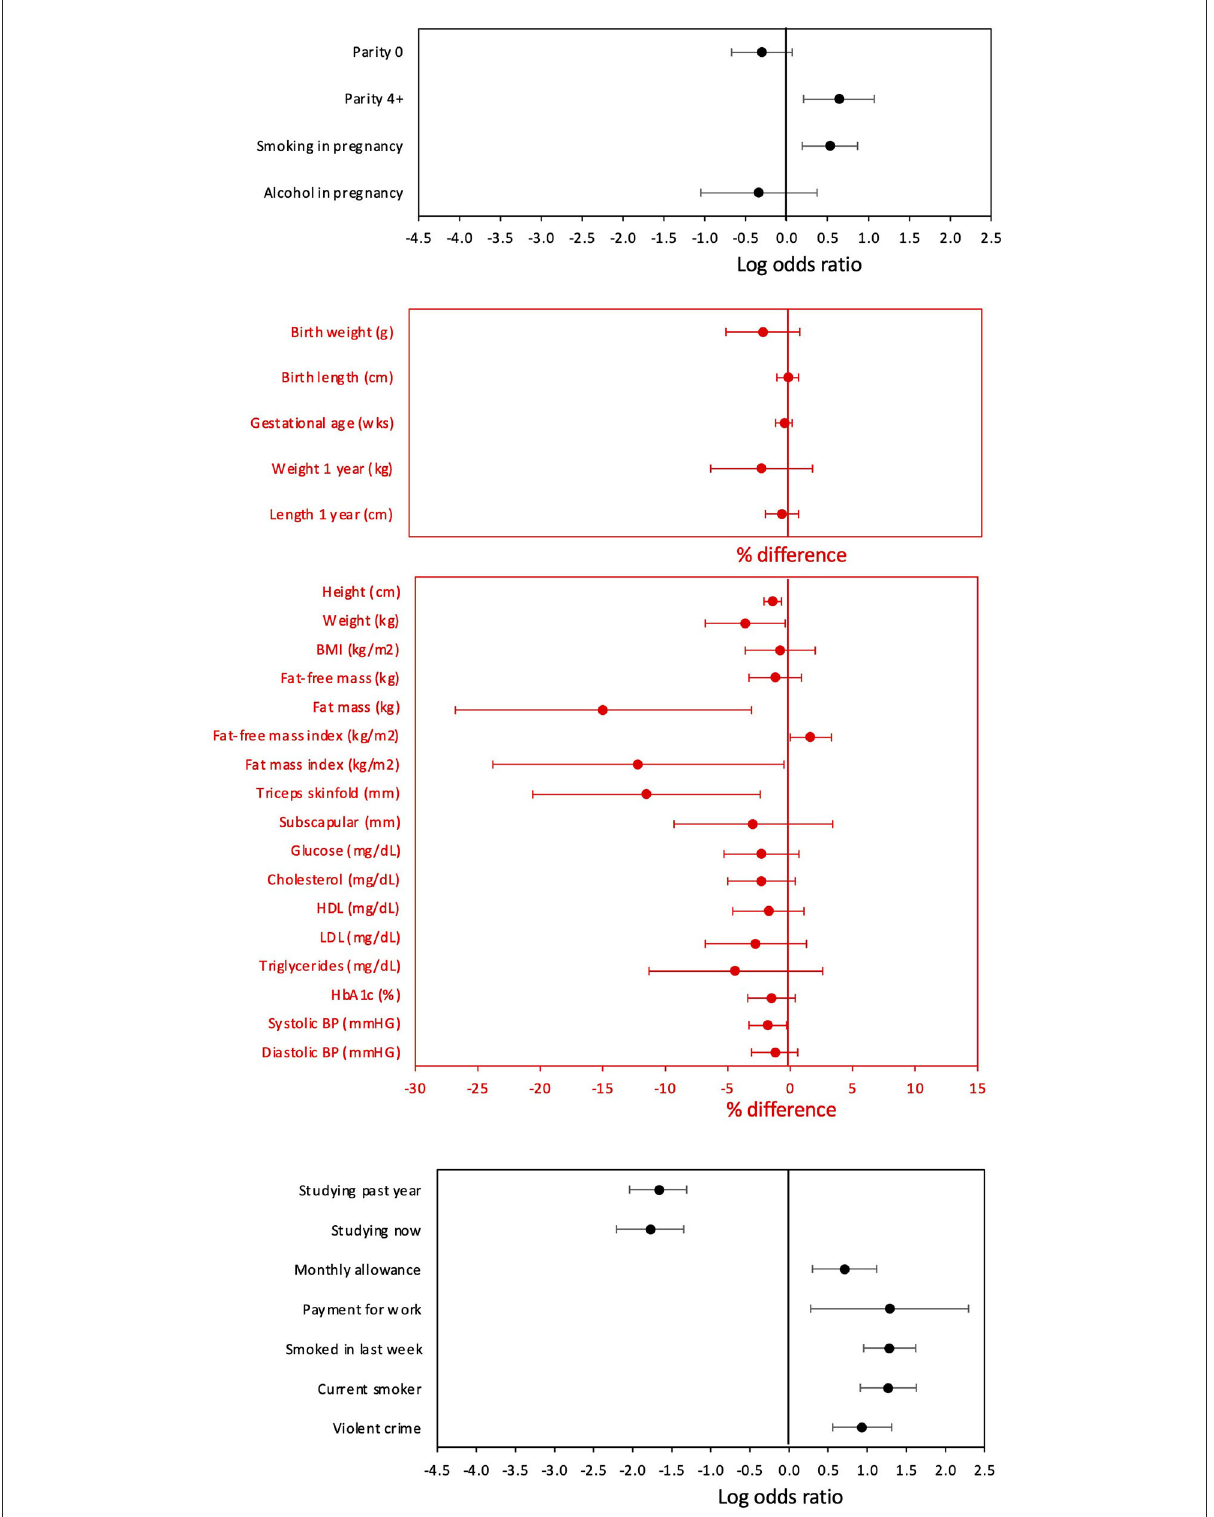
FIGURE2 Differences in maternal and son traits from pregnancy to adulthood between sons with or without offspring by 18 years. Categorical variables are shown as odds ratios on a log-scale and 95% confidence intervals. Continuous variables are shown as percent differences and 95% confidence intervals, calculated from natural log-transformed variables. Numerical values for all comparisons are given in Supplementary Table